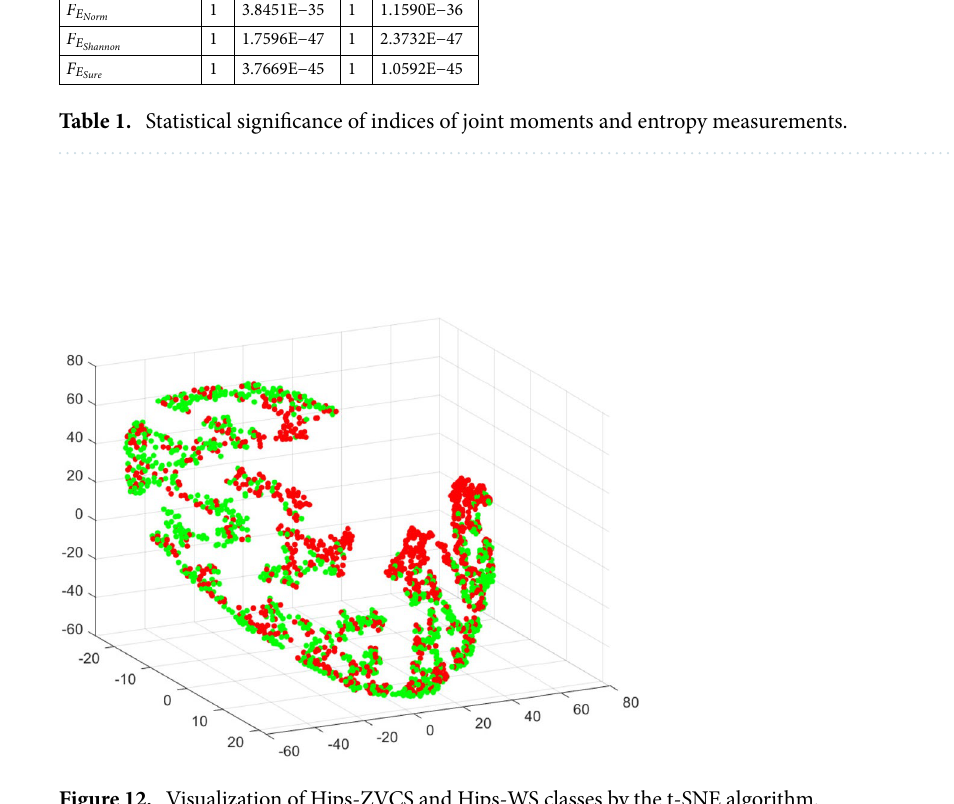
Figure 12. Visualization of Hips-ZVCS and Hips-WS classes by the t-SNE